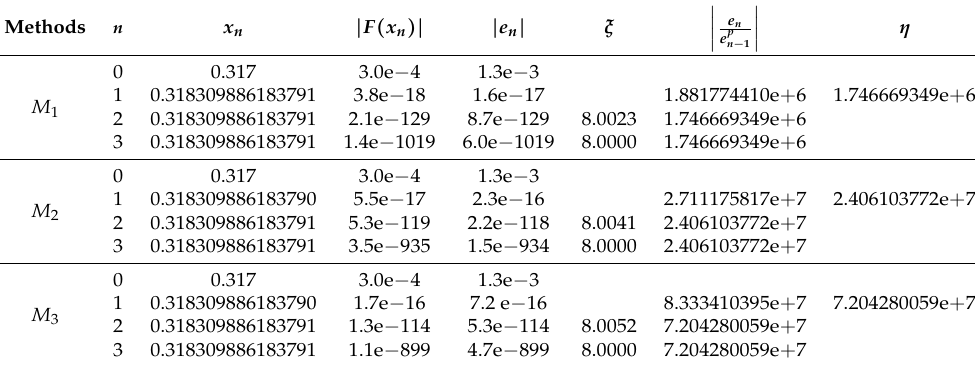
Table 8. Convergence behavior of different cases on Example